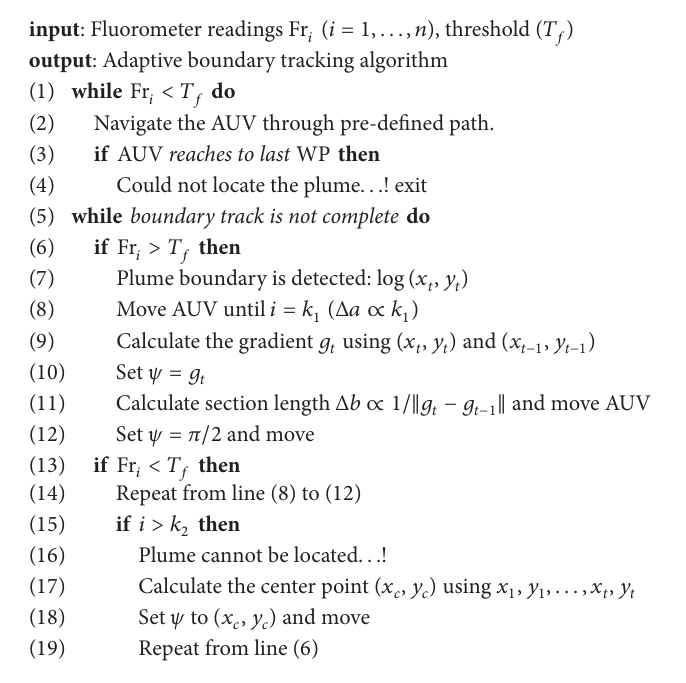
Algorithm 2: Plume boundary tracking